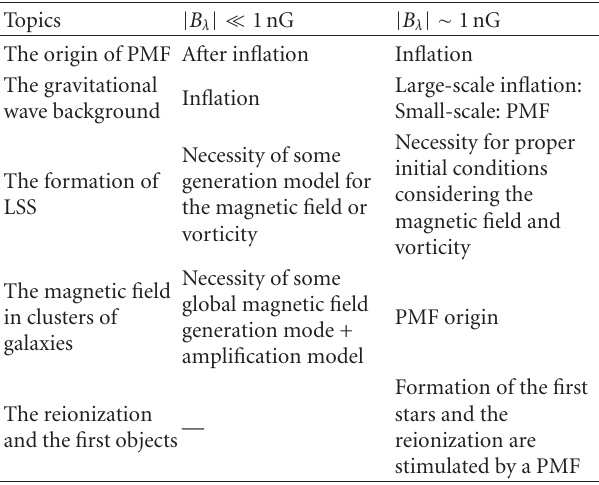
Table 2: E ff ects of the PMF on each physical